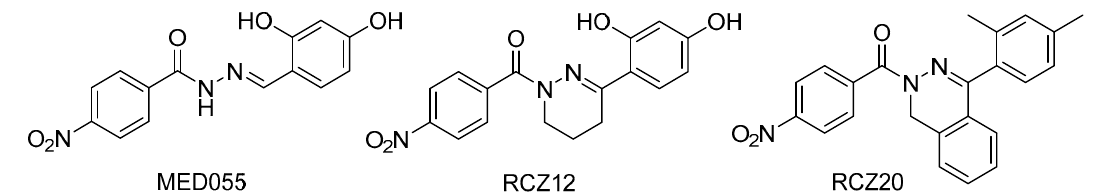
Figure 7. Structures of salicylidene acylhydrazides MED055, RC12, and